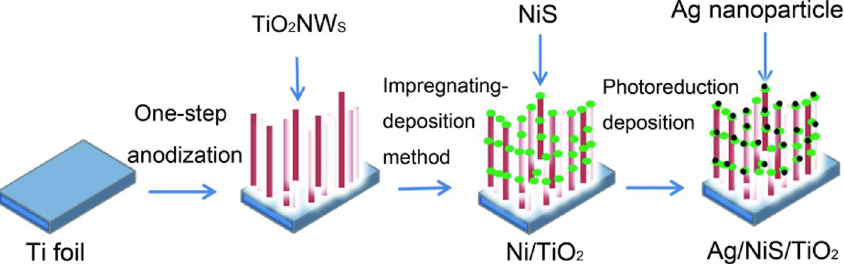
Figure 1. Schematic diagram of the procedures used to prepare the Ag/NiS/TiO 2